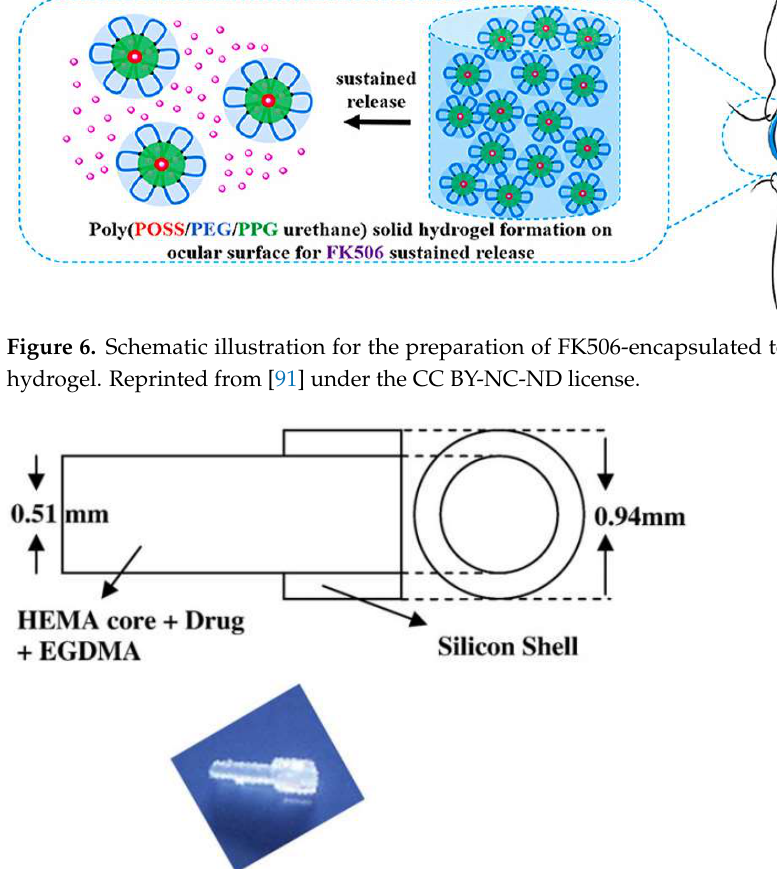
Figure 7. Schematic illustration for the design of a cyclosporine-releasing punctal plug. Reprinted with permission from [94]. Copyright 2011 Elsevier.